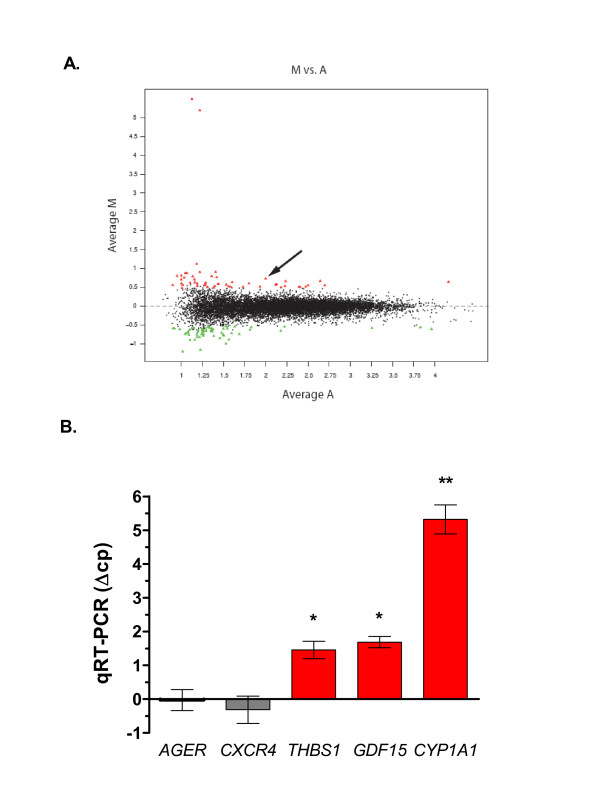
Tasquinimod effects on gene expression in LNCaP cells analyzed with DNA microarray. Altered gene expression induced by tasquinimod in LNCaP cell cultures. (A) Data plot of observed M ((M) = log2(Int1/Int2)) versus A (average intensity) from in vitro microarray experiment averaged over biological replicates (n = 4). THBS1 (arrow), GDF15 and CYP1A1 were significant outliers in all arrays analyzed (FDR < 10%; Table 1). (B) Validation of microarray data with semi-qRT-PCR confirmed the up-regulation of THBS, GDF14 and CYP1A1 (red bars; Δcp of 2.32 equals to a 5-fold change in mRNA expression). Expressed data represents the mean ± SD of at least two independent experiments. (*) p ≤ 0.05 and (**) p ≤ 0.01 compared with untreated control (Student's t-test).